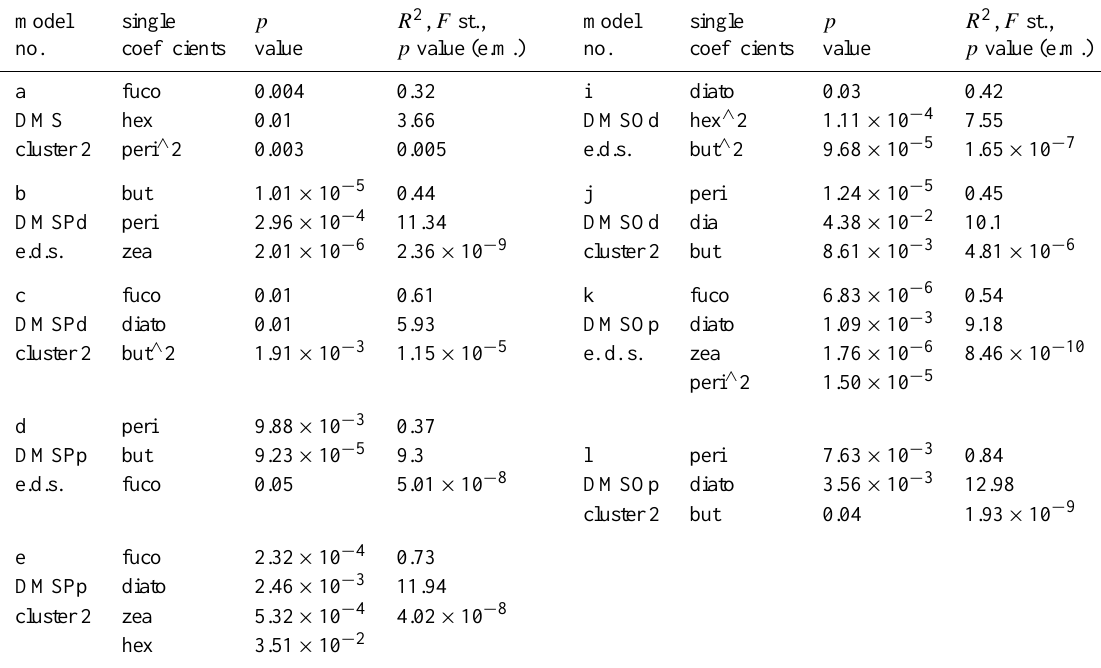
Table 3. Significant multiple linear regressions between DMS, DMSP and DMSO (d=dissolved, p=particulate, t=total) and phytoplankton marker pigments for the entire data set and within the clusters 2 and 4. Single coefficients and p values of each multiple linear regression model as well as R 2 , F statistic and p value of each entire model are given. The response variable is given under the model number. The independent variable squared shows a quadratic relationship to the response variable. The complete output of all models is given in the Supplement (the data presented here is extracted from Table 2 in the